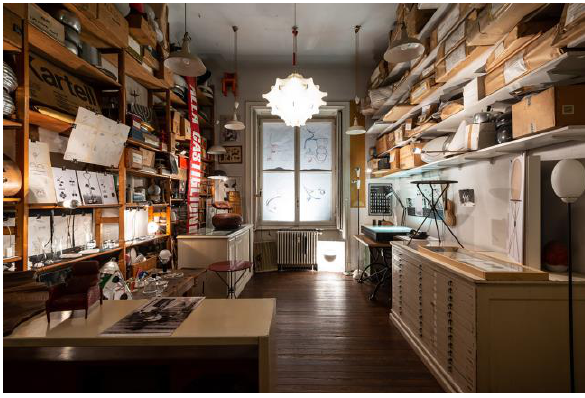
Figure 1. Prototypes Room, Studio Museo Achille Castiglioni. (© 2018, Fondazione Achille Castiglioni. Used with permission).